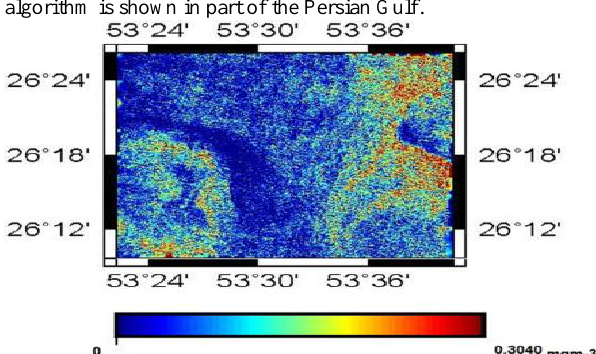
Figure 5. Estimated chlorophyll concentration using Landsat-8